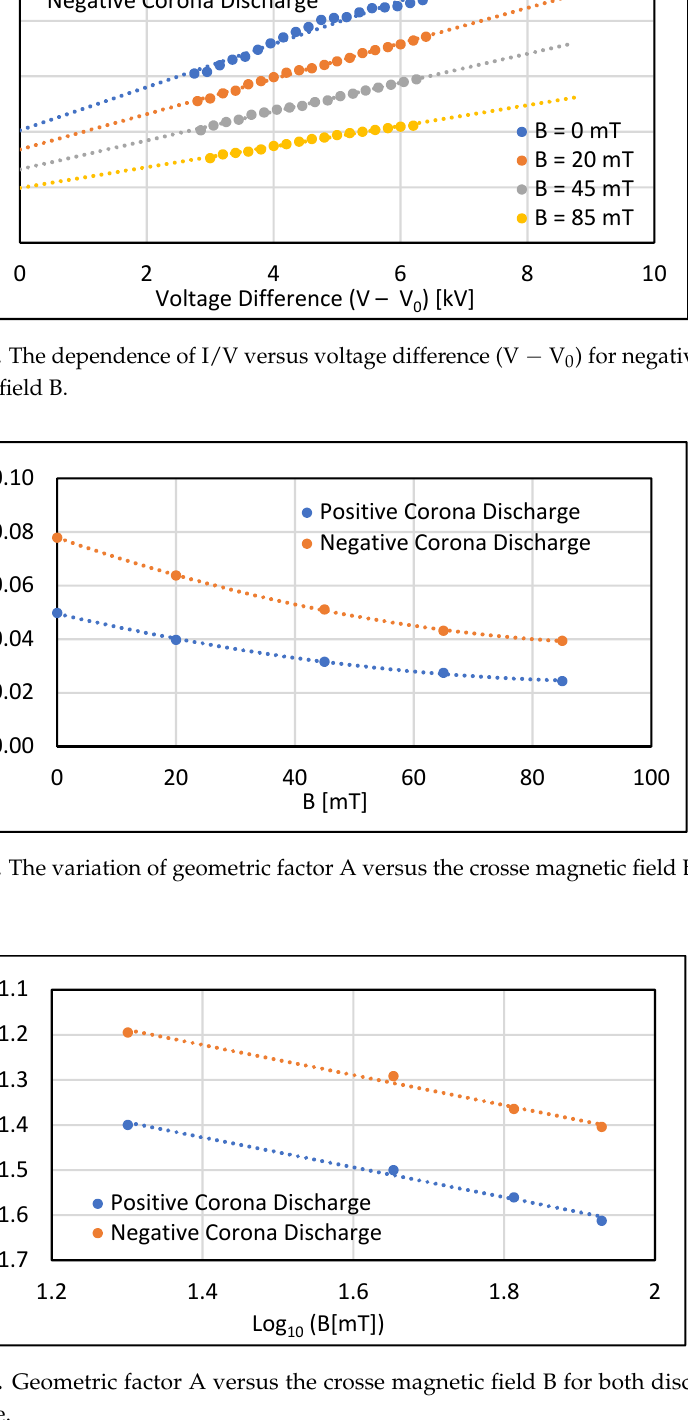
Figure 12. Geometric factor A versus the crosse magnetic field B for both discharge polarities on log 10 scale. From the curve fitting, a relationship was obtained individually for each discharge polarity that represents the variation of the geometrical factor A versus the crossed mag- netic field B as follows.